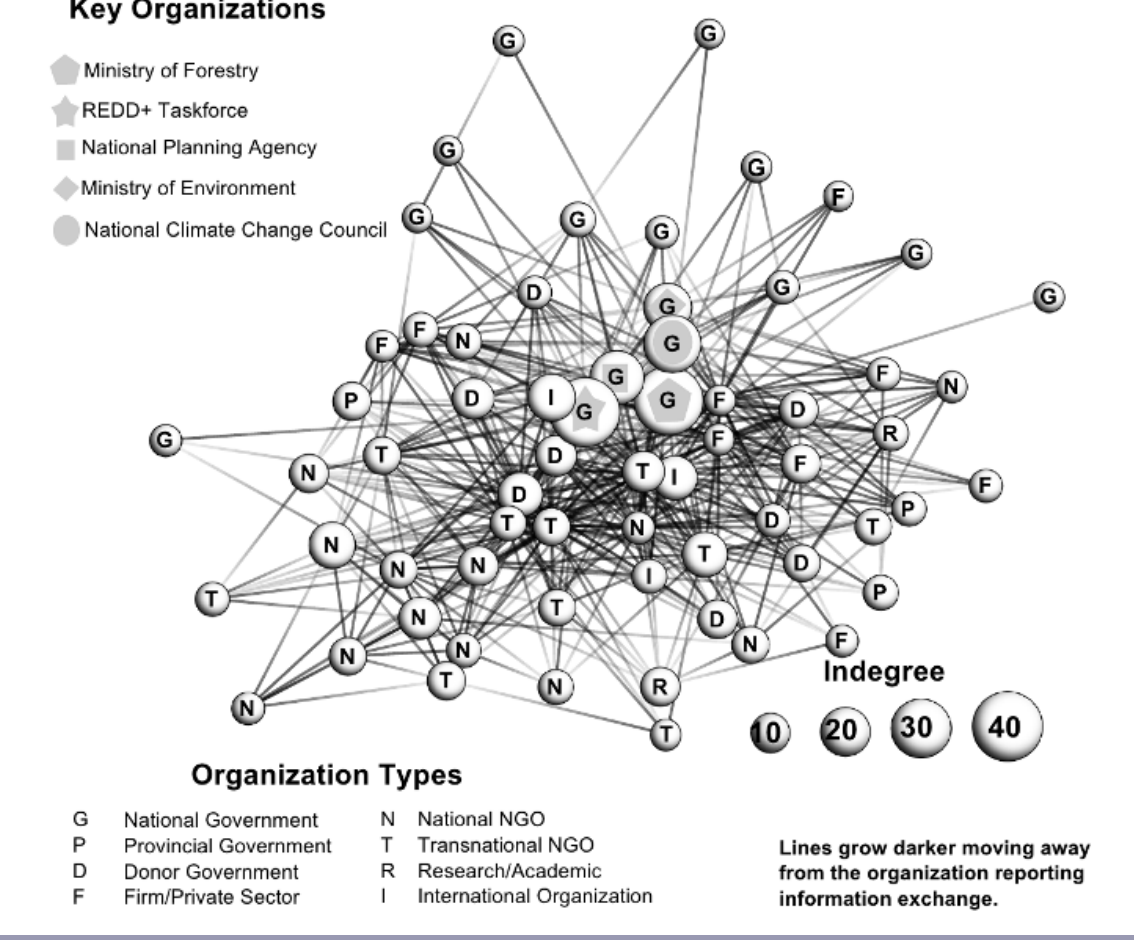
Fig. 2 . Directed network of information exchange between actors in the REDD+ policy arena (outdegree).